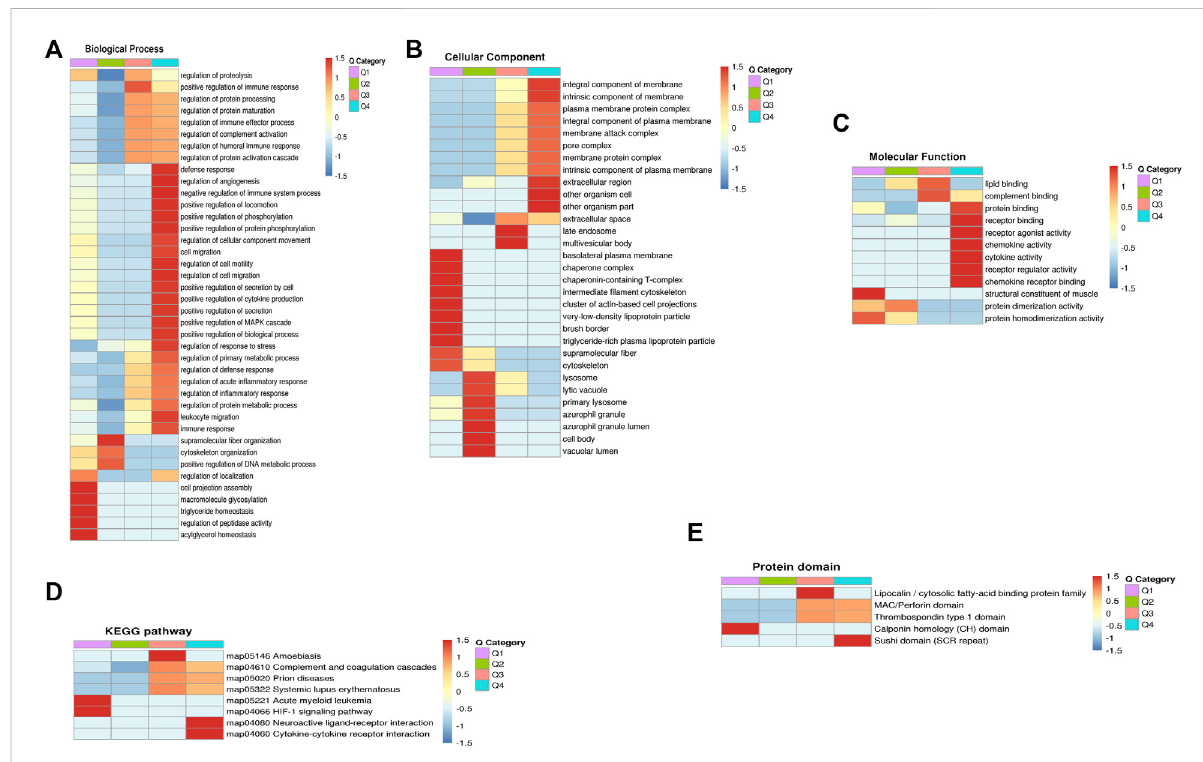
FIGURE 3 Functional enrichment-based clustering analyses of dofferentially expressed proteins in follicular fl uid of PCOS patients and controls. (A) Biological process analysis (B) Cellular component analysis. (C) Molecular function analysis (D) KEGG pathway analysis (E) Protein domain